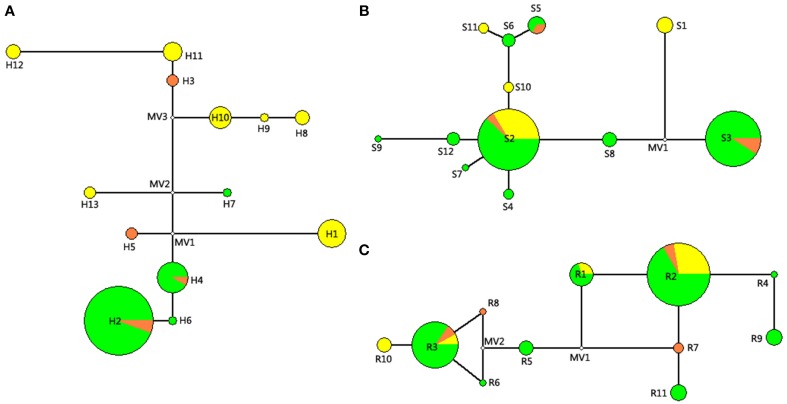
Networks of the combined cpDNA sequence (A), nDNA SmHP (B), and nDNA RPB1 (C) haplotypes of studied Cycas species. Each circle represents one haplotype. The size of the circles corresponds to the frequency of each haplotype, and the small hollow circles indicate hypothetical missing haplotype. For different colors in this figure: Green, C. diananensis, yellow, C. parvula, orange, C. multiovula.